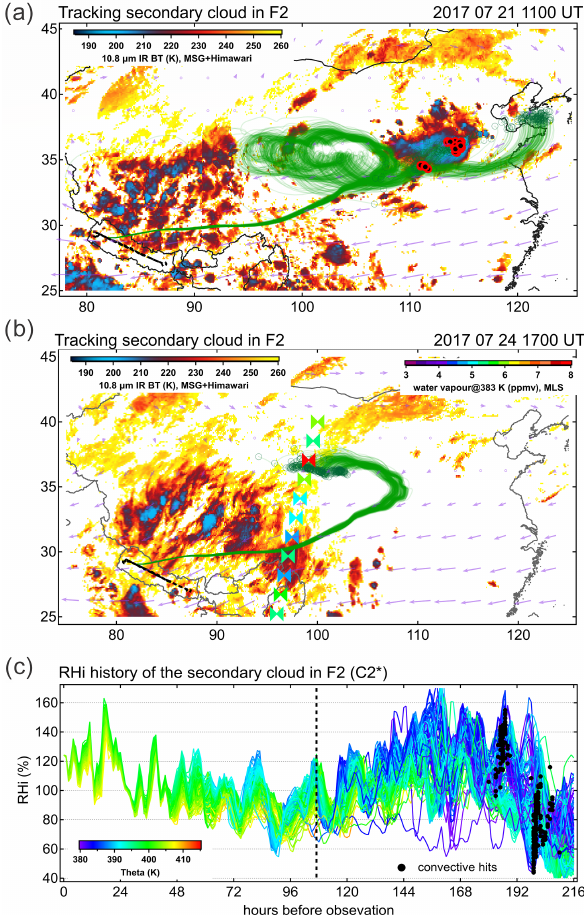
Figure 7. Trajectory analysis of the secondary cloud (C2) detected in F2 (29 July). (a) Back trajectories (green curves) and convec- tive hits locations (black-filled red circles) superimposed onto the infrared brightness temperature (IR BT) at the time of convective hits (cf. time stamp in the panel). (b) Same as panel (a) but for the time of the MLS sampling of the moist plume. The spatiotemporally collocated MLS swath is displayed as markers colour-coded by the H 2 O mixing ratio at the 393K level. The wettest MLS measure- ment coincides with the location of hydrated parcels. (c) Relative humidity over ice evolution along the back trajectories with colour coding by potential temperature computed from ERA5 temperature and assumed H 2 O mixing ratio of 12ppmv (see text for details). The black markers show the locations of convective hits, and the vertical dashed line indicates the time of MLS sampling of the moist plume on 24